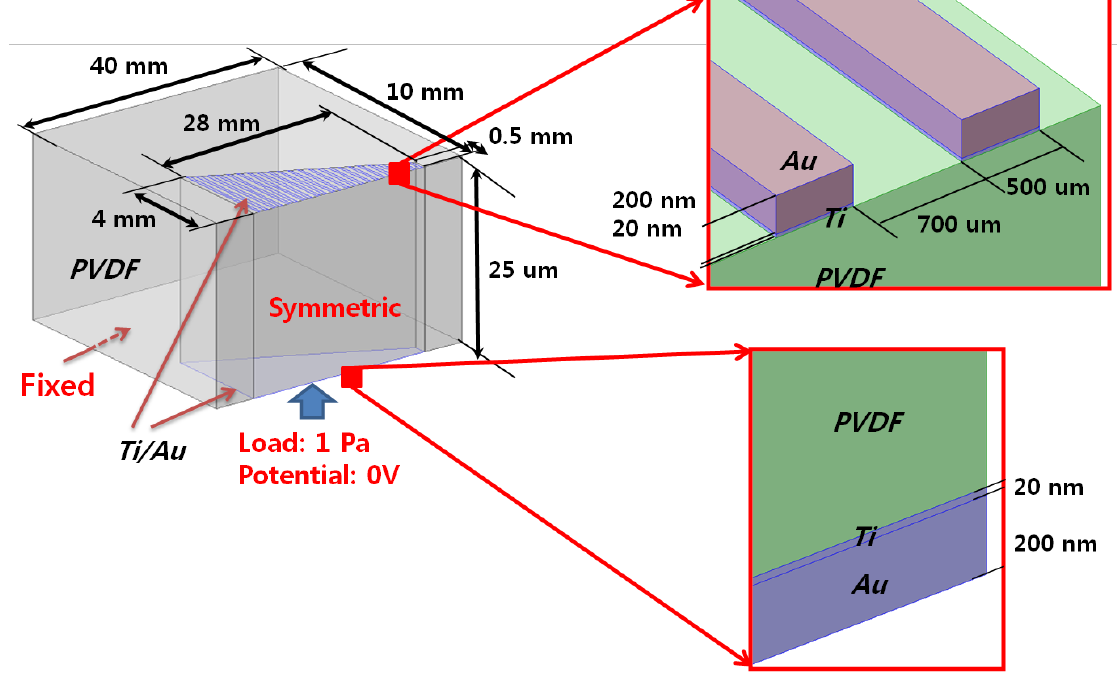
Figure 2. Finite element model geometry and boundary/load